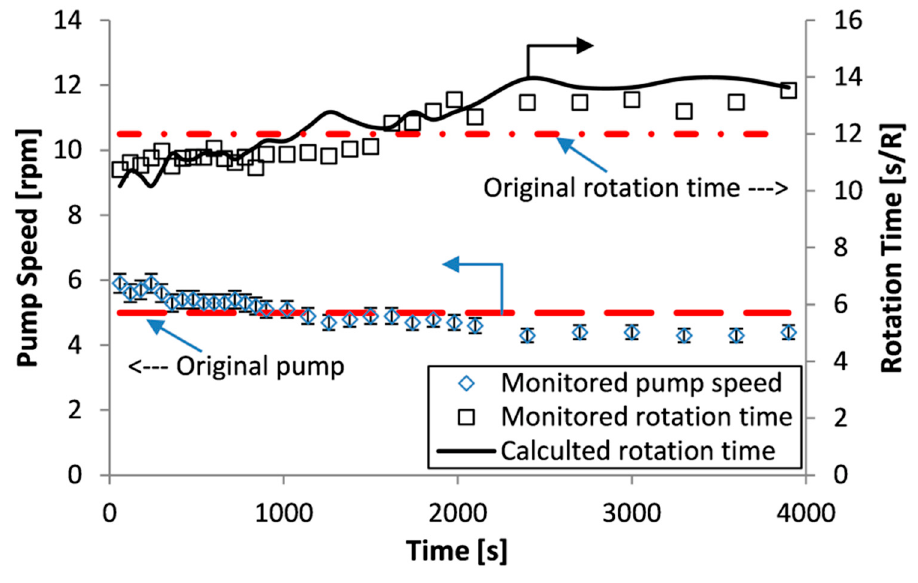
Figure 7. Investigation on the variation of pump speed and rotation time during the filtration of talc at initial concentration of 0.05 v / v , using a pump speed of 5 rpm.